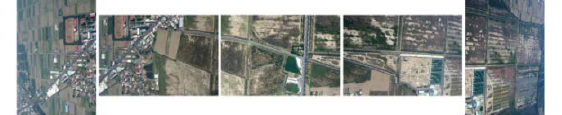
Figure 5. Example of multi-camera image group in a single shot